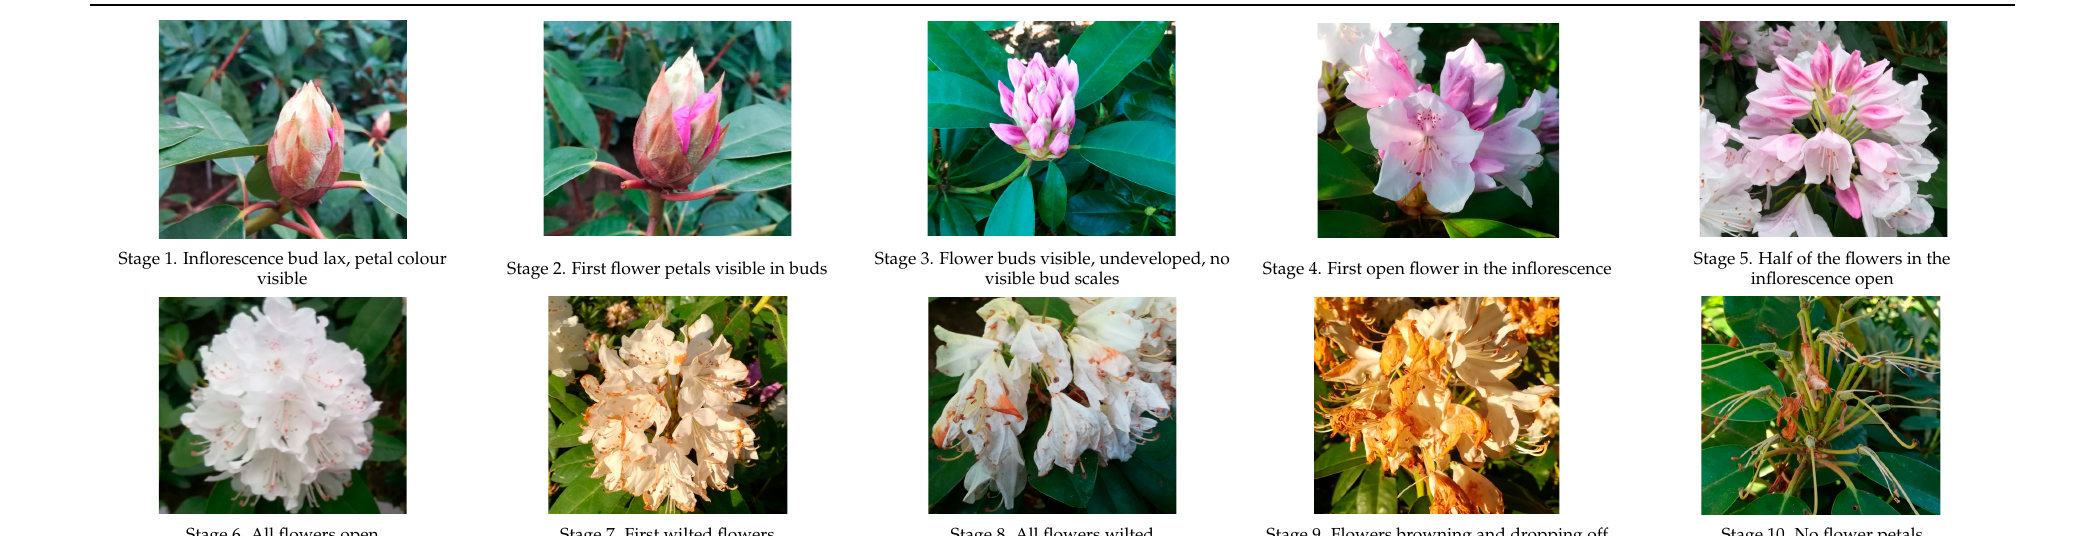
Table 2. Flower development scale used in the work.